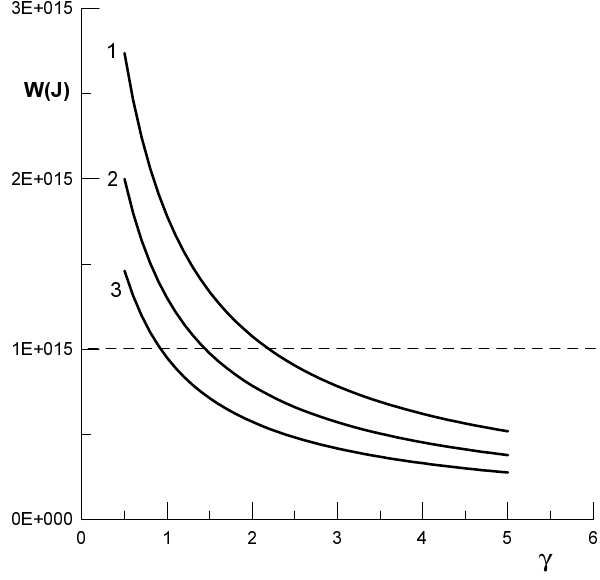
Fig. 5. Dependence of the total energy W supplied into the mag- netosphere with the “geoeffective” energy flux during the time 1t = 3 × 10 3 s on the growth intensity index of the tail γ in the model Eq. (21). Curve numbers correspond to different thick- nesses of the transition layer: 1 – 1 = 0, 2 – 1 = 10 4 km, 3 – 1 = 2 × 10 4